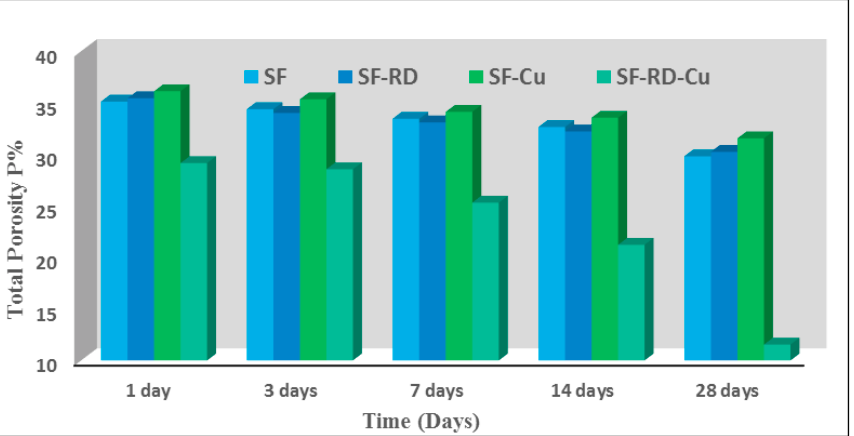
Figure 5. Total porosity% of different geopolymer cement mixes after curing in different hydration ages. tion